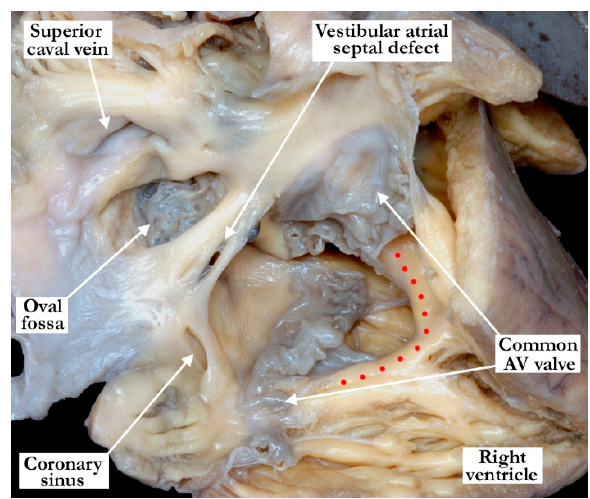
Figure 3. This heart with a common atrioventricular junction guarded by a common valve is viewed from the right ventricle, with the ventricular septum marked with red dots. There is a competent flap valve at the floor of the oval fossa, and a vestibular septal defect in the antero-inferior muscular rim, directly adjacent to the atrial component of the atrioventricular septal defect.